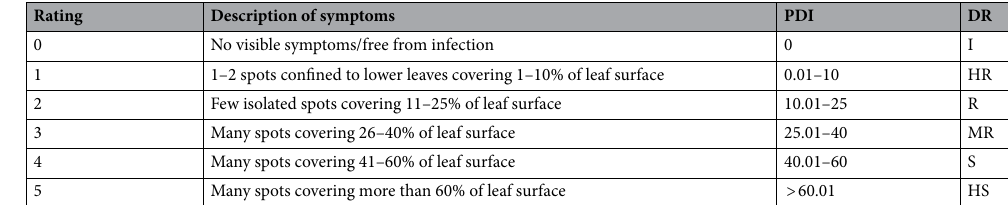
Table 6. Disease rating scale for early blight disease on leaves of tomato plant. PDI percent disease index, DR disease response, I immune, HR highly resistant, R resistant, MR moderately resistant, S susceptible, HS highly